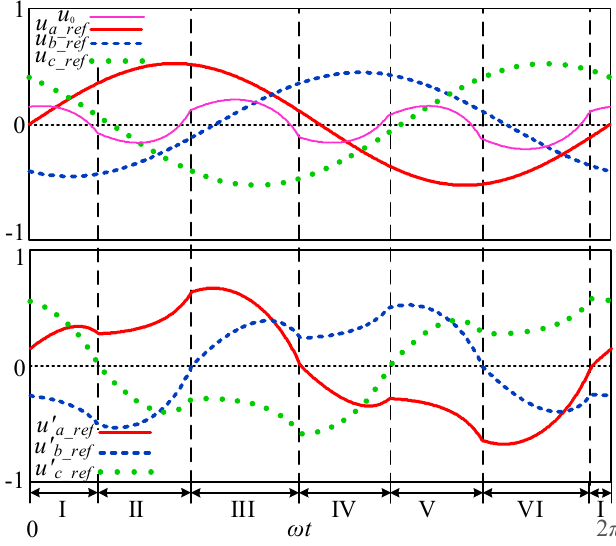
Figure 4. Three phase modulation signals with u 0 in different regions under the non-ideal grid condition.